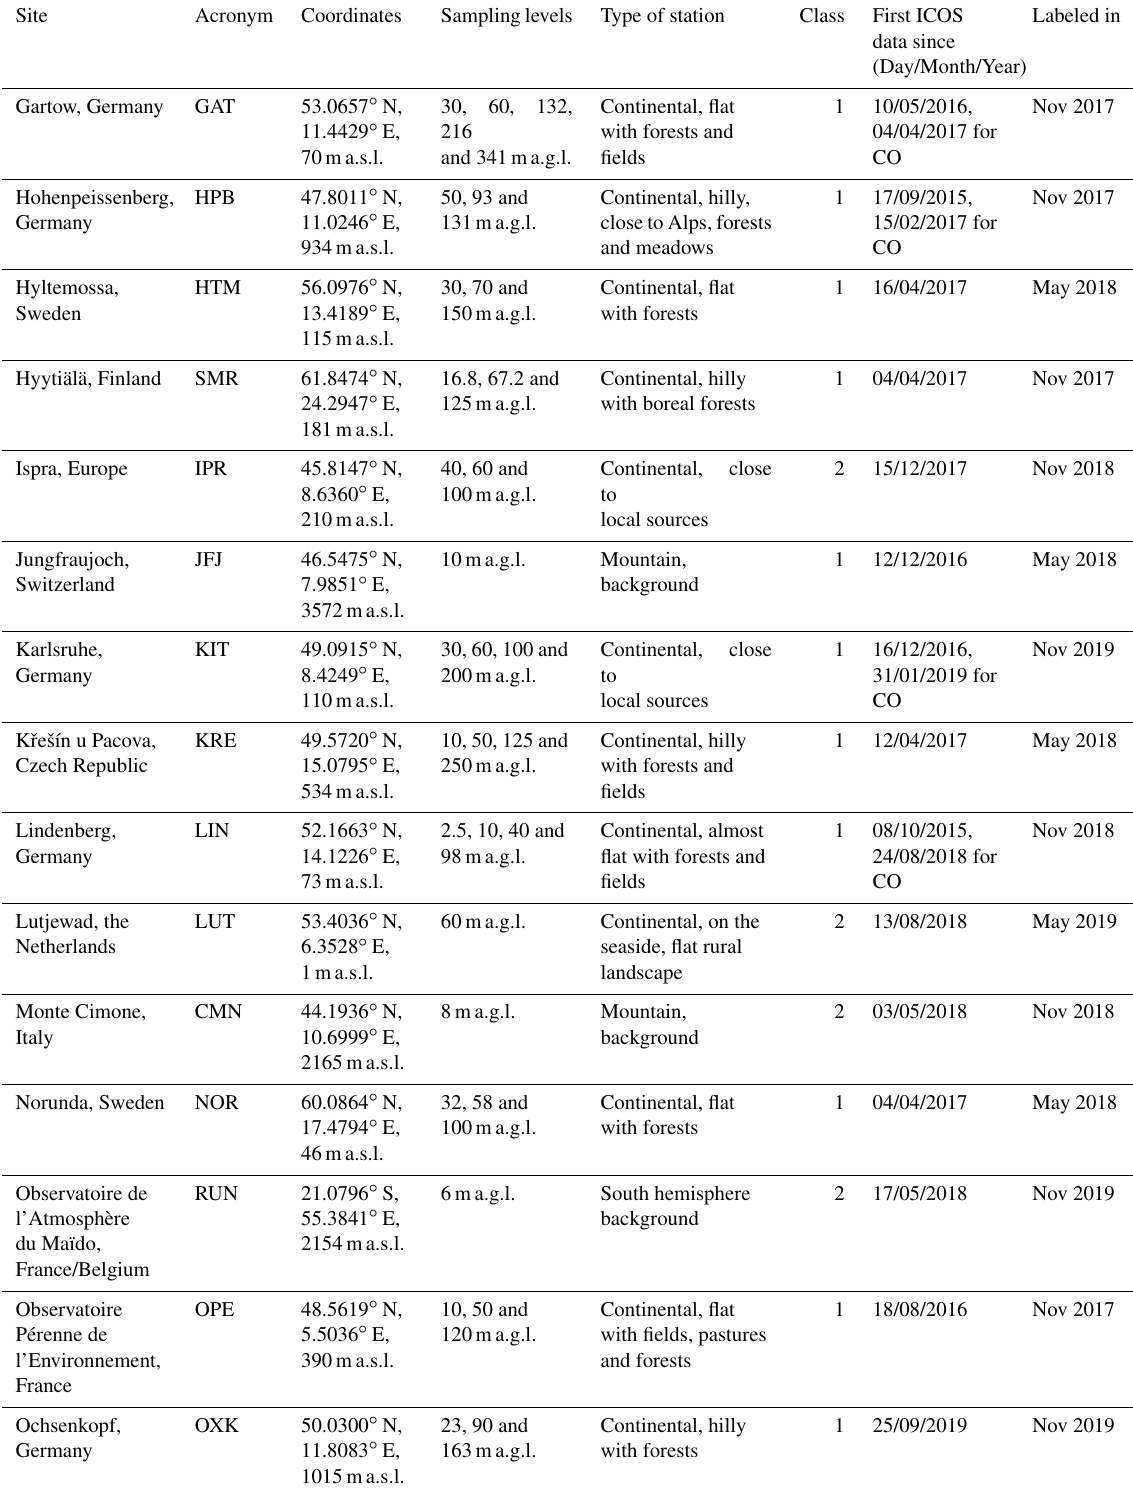
Table 3. Information about the 23 labeled stations: site name, three-letter acronym, coordinates, sampling level heights, station surroundings, class, date of the first ICOS compliant data and date of labeling. The abbreviations a.s.l. and a.g.l. signify above sea level and above ground level,